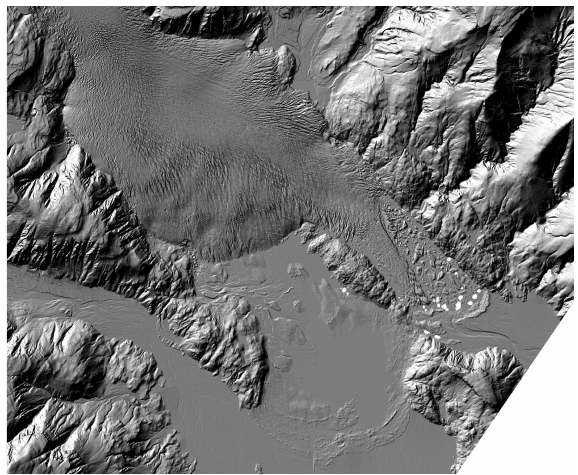
Fig. 3. A topographic relief shading showing the August 2010 Li- DAR DEM of the terminus and the lower part of Hoffellsjökull. The LIA terminus moraines can be seen in front of the terminus as well as the extensive break-up of the eastern branch of the terminus into the lake in front of the glacier that occurred in